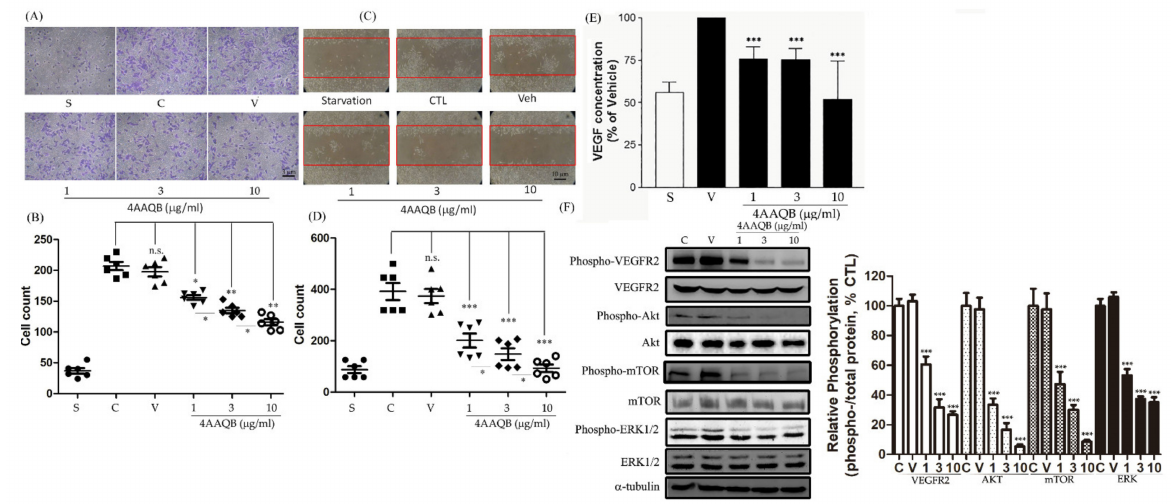
Figure 2. The compound, 4AAQB, inhibits PC3 cell migration, VEGF production, and signaling path- way proteins phosphorylation. ( A ) Migrated PC3 cells in the underside filter membrane were quanti- fied (three fields per filter) by phase-contrast light microscopy. Data are represented as means ± SEM ( n = 6). The cell number were calculated and are shown in ( B ); ( C ) wound-healing migration of PC3 cell monolayers treated with the vehicle or various doses of 4AAQB for 24 h. Data are represented as means ± SEM ( n = 6). The cell numbers were calculated and are shown in ( D ); ( E ) VEGF protein expression was evaluated by ELISA and data are represented as means ± SEM ( n = 6); ( F ) the PC3 cells’ protein phosphorylation was detected by Western blotting. Relative phosphorylation of protein is presented as mean density for the ratio between phosphorylated protein and total protein as determined by ImageJ. Data are represented as means ± SEM ( n = 3). * p < 0.05, ** p < 0.01, and *** p < 0.001 compared to the control (C) or vehicle (V) groups. S indicates the starvation group. NS: non-significance.